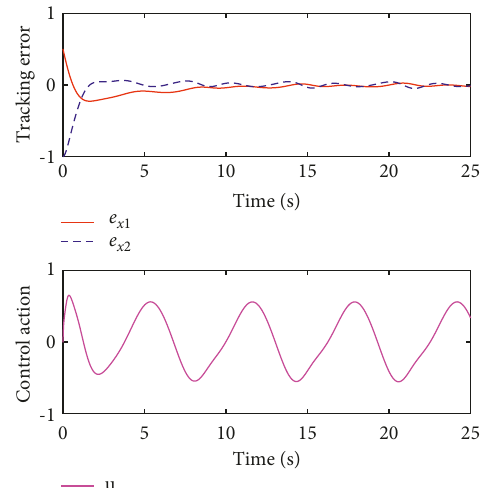
Figure 9: Tracking error and proposed control action with (34) (case 2).